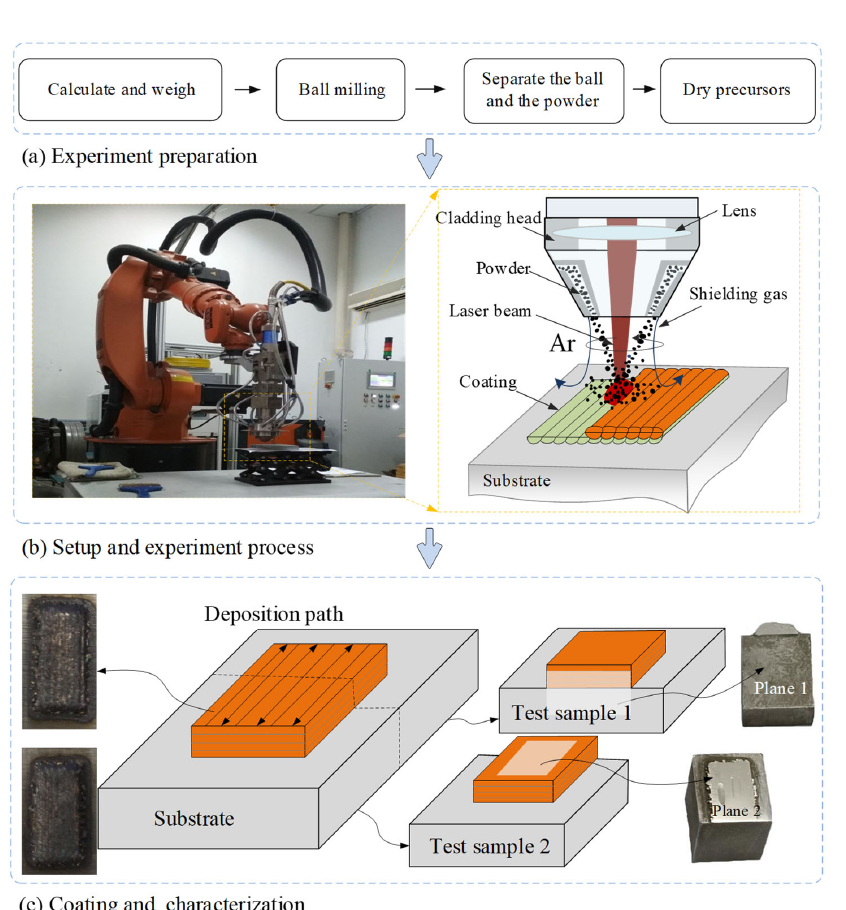
Figure 1. Laser cladding process and test characterization.